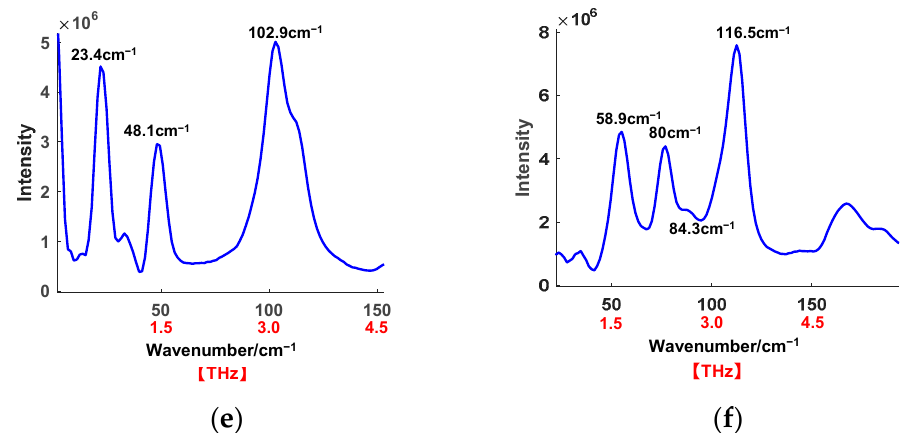
Figure 4. ( a ) Terahertz Raman spectrum of DL-leucine; ( b ) terahertz Raman spectrum of DL-tartaric acid; (c) terahertz Raman spectrum of DL-threonine; ( d ) terahertz Raman spectrum of L-malic acid; ( e ) terahertz Raman spectrum of fumaric acid; and ( f ) terahertz Raman spectrum of glycine.